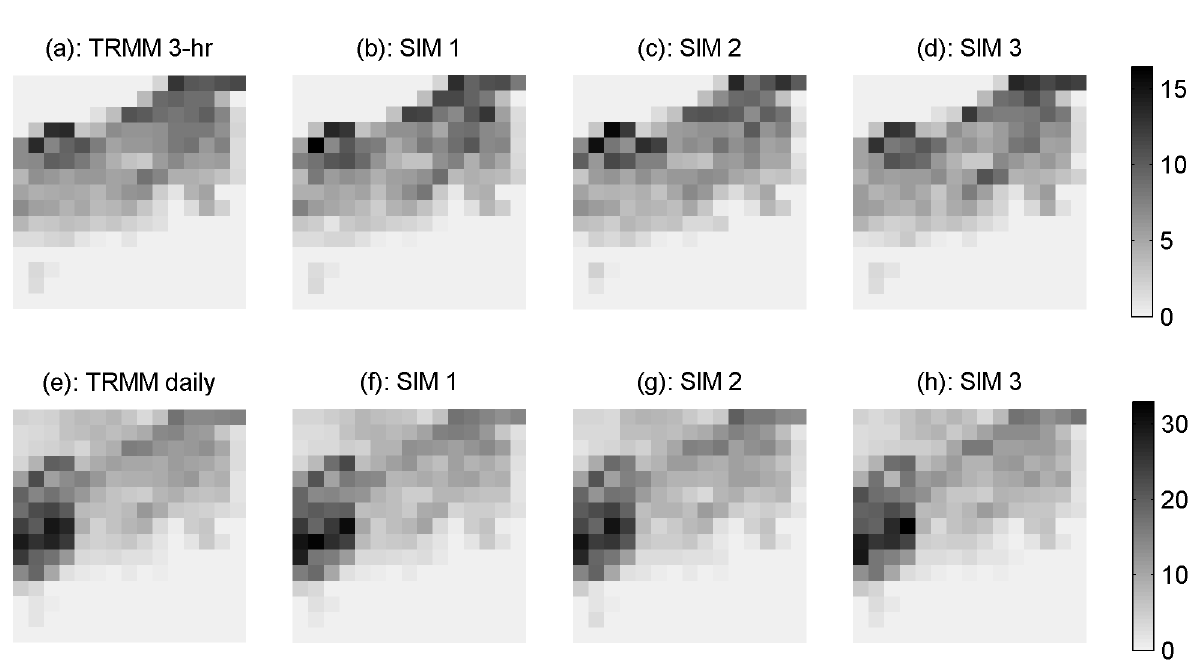
Figure 2. Observed [(a): 3-hr; (e): daily] and simulated ((b) to (d): 3-hr; (f) to (h): daily) TRMM precipitation fields (SIM: